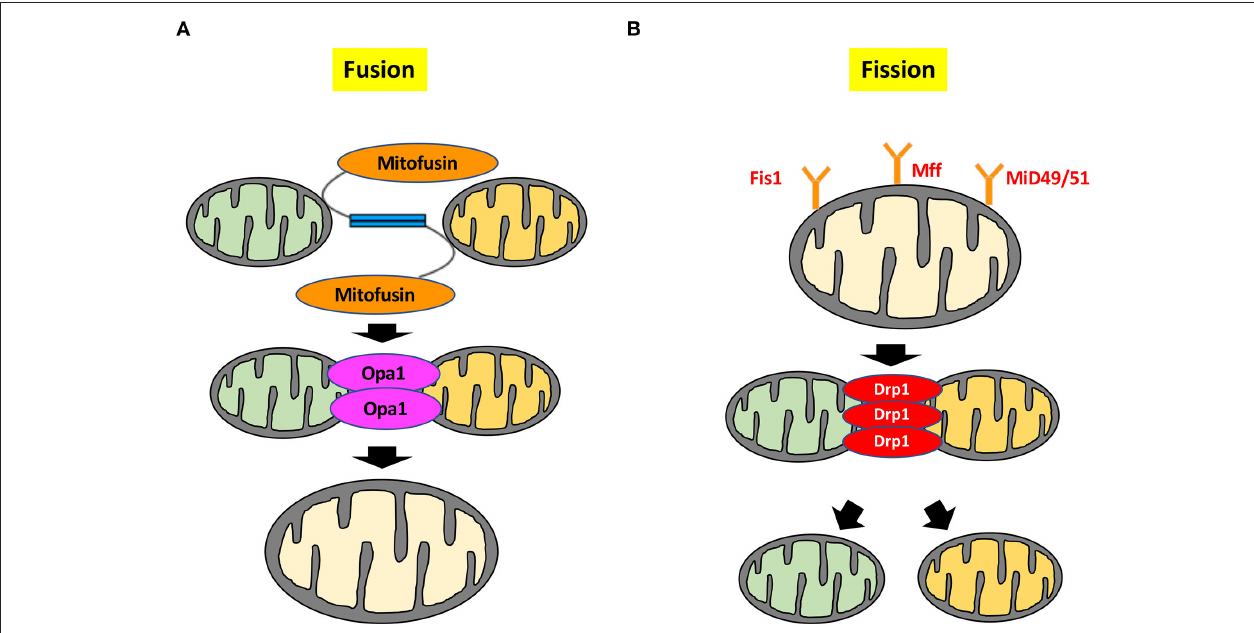
FIGURE 1 | Molecular mechanisms of mitochondrial dynamics. (A) Mitochondrial fusion is controlled by Mfn1, Mfn2, and Opa1. Mfn1 and Mfn2 are located on the outer mitochondrial membrane, whereas Opa1 is located on the inner mitochondrial membrane to maintain the integrity of the cristae. (B) Mitochondrial fission is regulated by small GTPase Drp1. Drp1 is mainly localized in the cytosol, whereas Drp1 localizes to the outer mitochondrial membrane by several stimuli. Drp1 forms a complex with the outer mitochondrial membrane proteins Mff, Mid, and Fis1 to drive the mitochondrial fission process. Deformation of the mitochondrial membrane is caused by formation of the Drp1 complex, leading to mitochondrial division. Mid49/51; mitochondrial dynamics protein of 49 and 51 kDa.